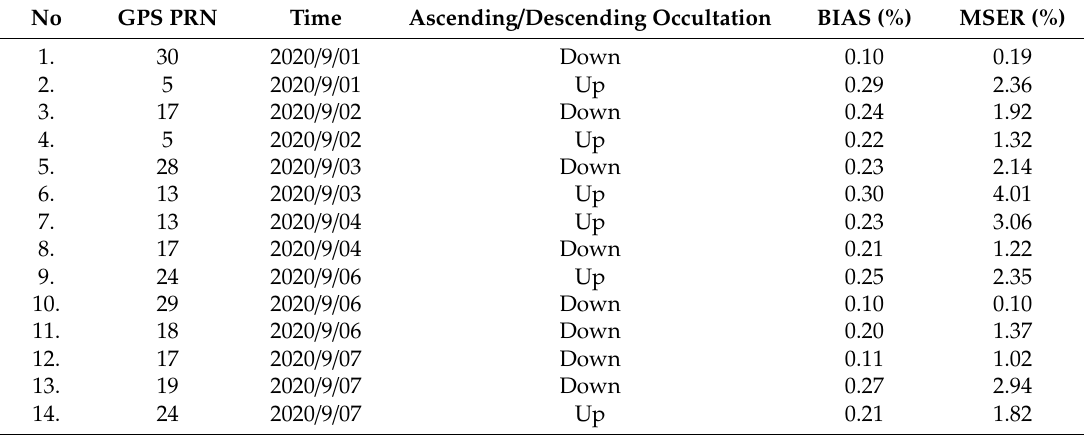
Table 2. The relative refractive index deviation standard deviation statics of each atmosphere